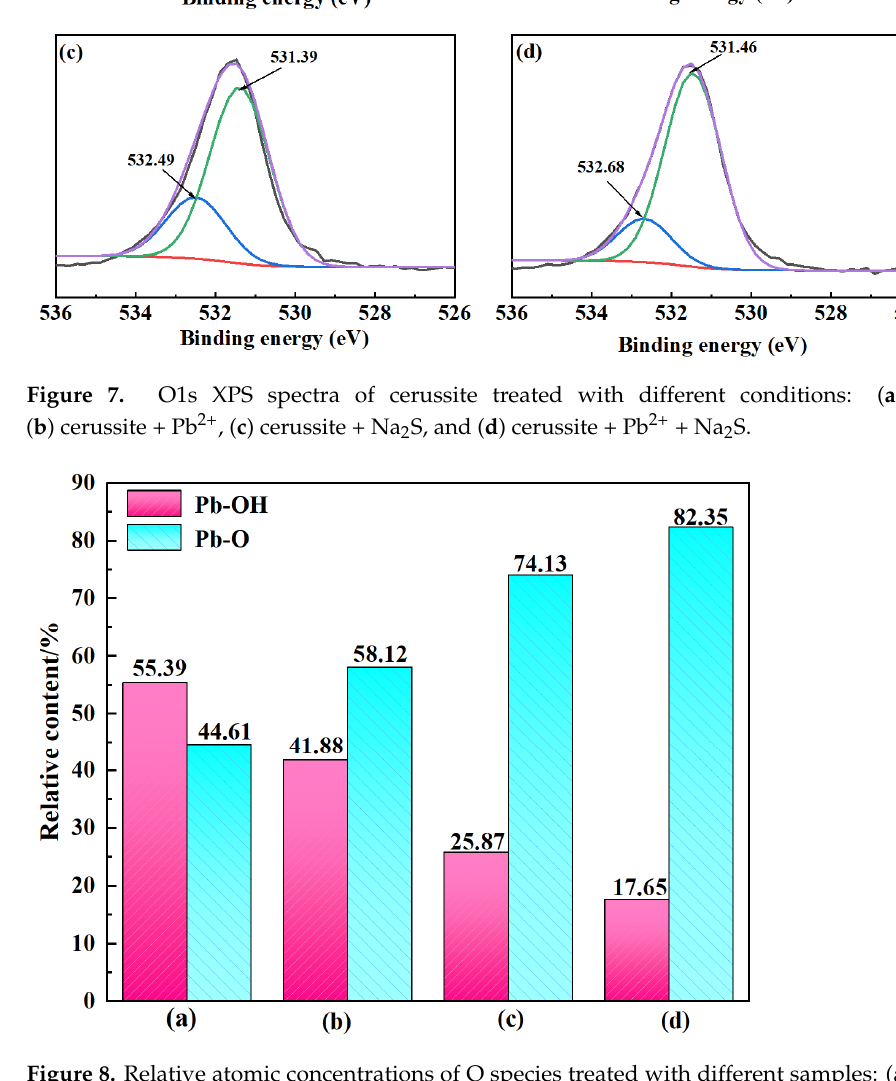
Figure 8. Relative atomic concentrations of O species treated with different samples: ( a ) cerussite, ( b ) cerussite + Pb 2+ , ( c ) cerussite + Na 2 S, and ( d ) cerussite + Pb 2+ + Na 2 S.